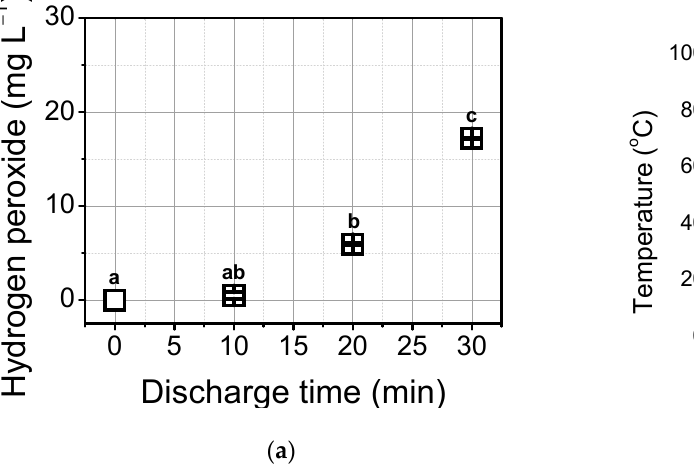
Figure 3. The characteristics of underwater PTWB. ( a ) The concentration of hydrogen peroxide; ( b ) the changes in temperature, pH, and salinity. Different letters indicate significant differences ( p < 0.05).